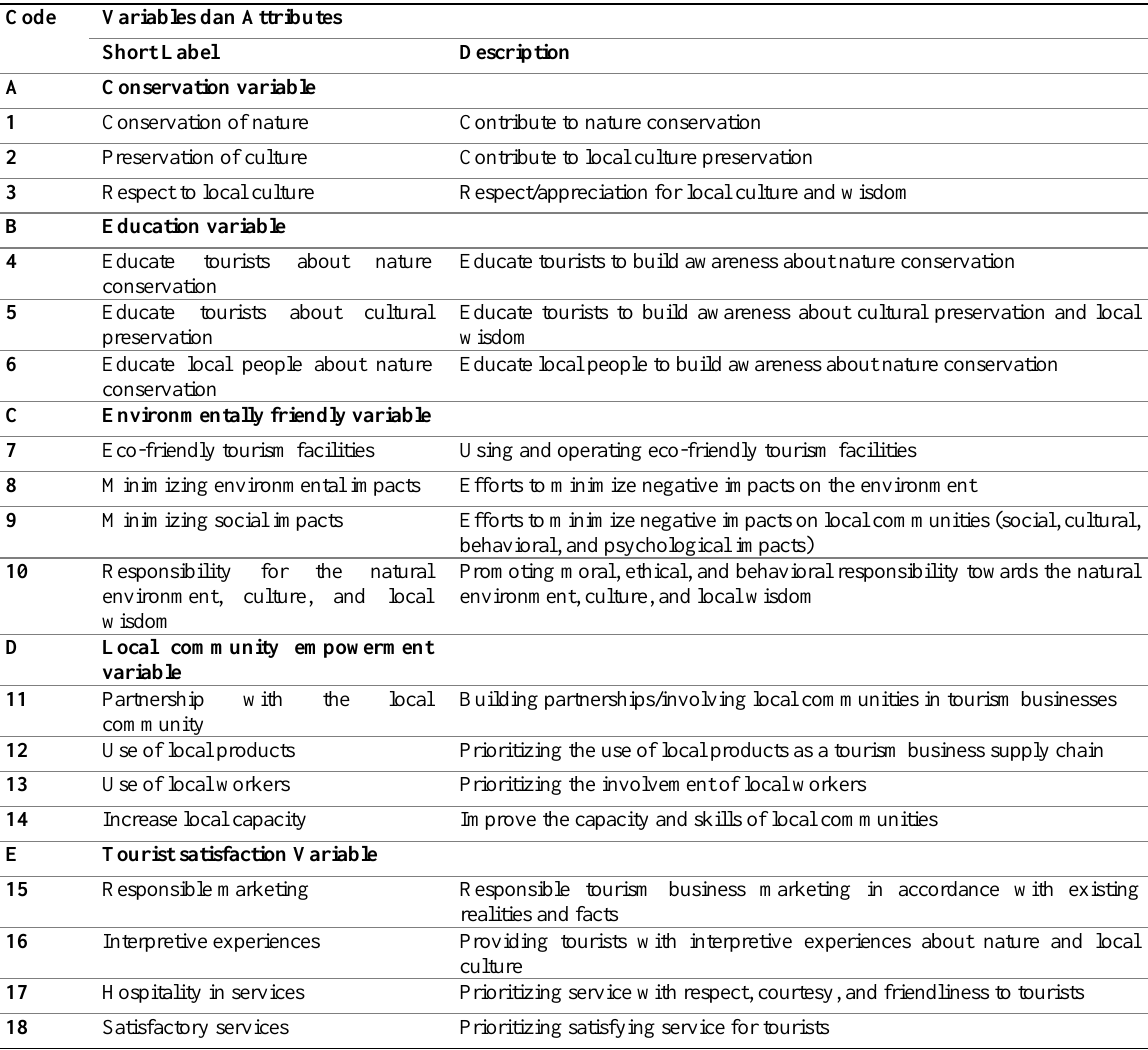
Table 1: Variables and attributes used to evaluate the implementation of ecotourism principles by dive operators in Bali